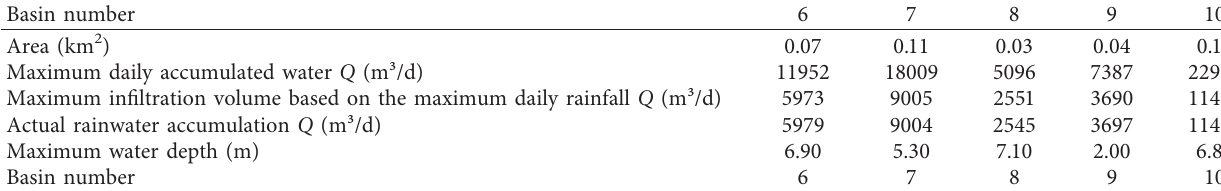
Table 5: Highly accurate solutions of the rainwater accumulation in other inner